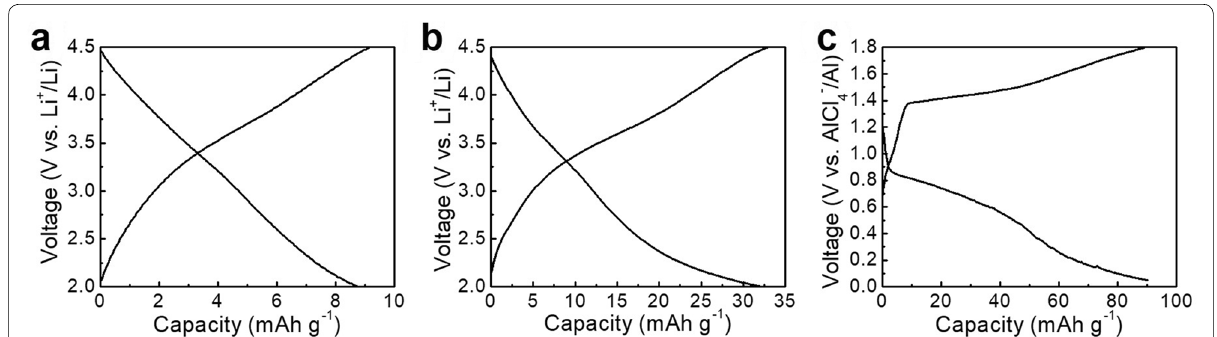
Fig. 6 Voltage profiles of a bare C and b Sm/C when used for Li‑ion storage. Voltage profiles of c Sm/C when used for Al‑ion